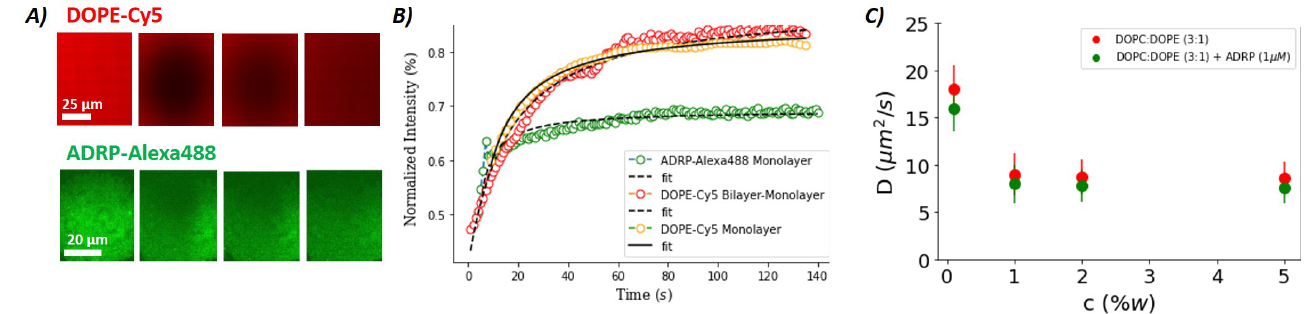
Figure 3. ( A ) Series of fluorescence images showing a lipid monolayer (DOPC:DOPE, 3:1) between buffer and triolein before bleaching and during recovery. (Upper panel) DOPE-Cy5, 2% molar ratio; (Lower panel) ADRP-Alexa488, 1 µ M. ( B ) FRAP curves extracted from fluorescence images, such as the one shown in ( A ) with the corresponding Soumpasis fits for DOPE-Cy5 (red dots) and ADRP- Alexa488 (green dots). Yellow dots correspond to the recovery of the DOPE-Cy5 fluorescence obtained by bleaching the entire bilayer-embedded LD surface, with same bilayer composition as in ( A ). ( C ) Diffusion coefficients of DOPE in the lipid monolayer, as a function of total lipid concentration and in the presence and absence of ADRP. The error bars are presented by the continuous lines. In ( A – C ), each value was obtained by averaging ≈ 30 different